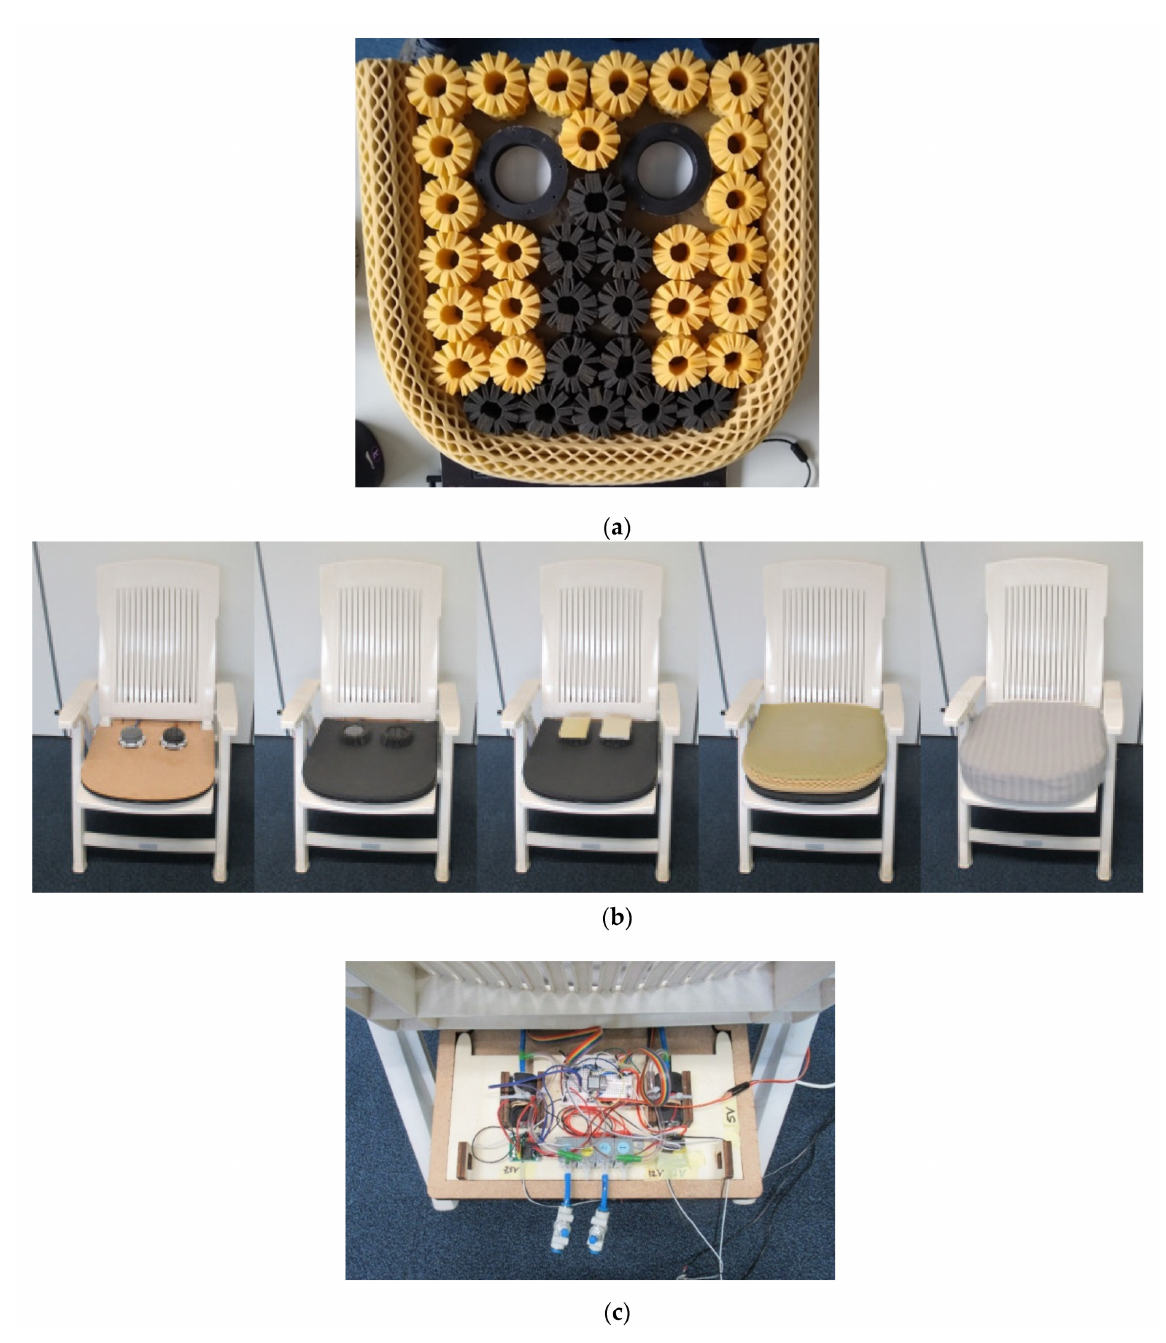
Figure 8. Integration of the soft robotics modules in the chair. ( a ) Octaspring and the space for the soft robotics module in the cushion (as viewed from underneath); ( b ) install the soft robotics module to the chair; ( c ) electronic and pneumatic components positioned under the seat